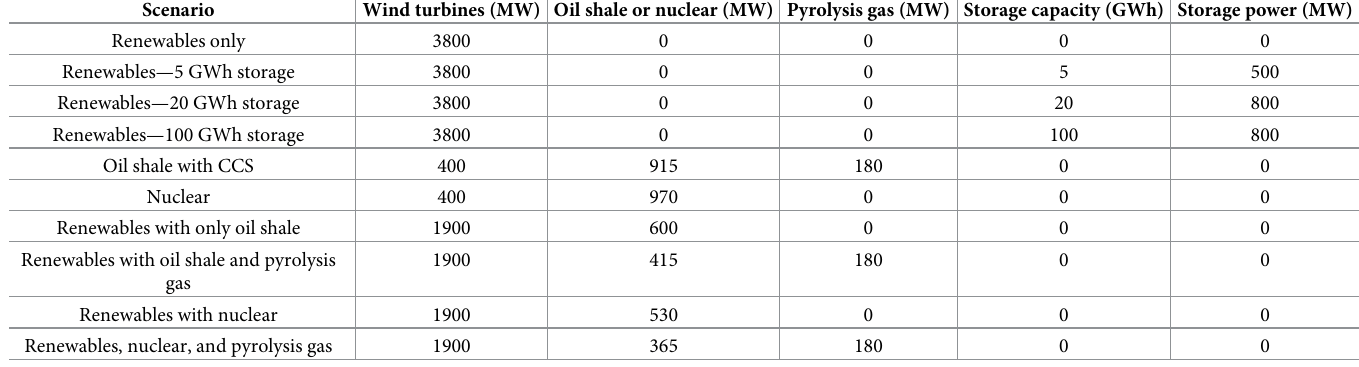
Table 1. Overview of the scenarios compared �